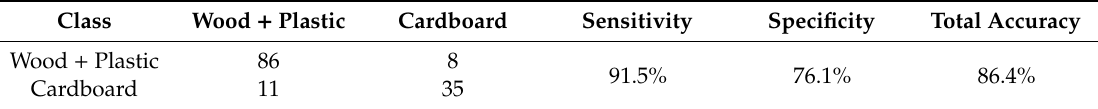
Table 7. DSVM classification performance for classifying cardboard vs. the rest using SKF cross-validation.